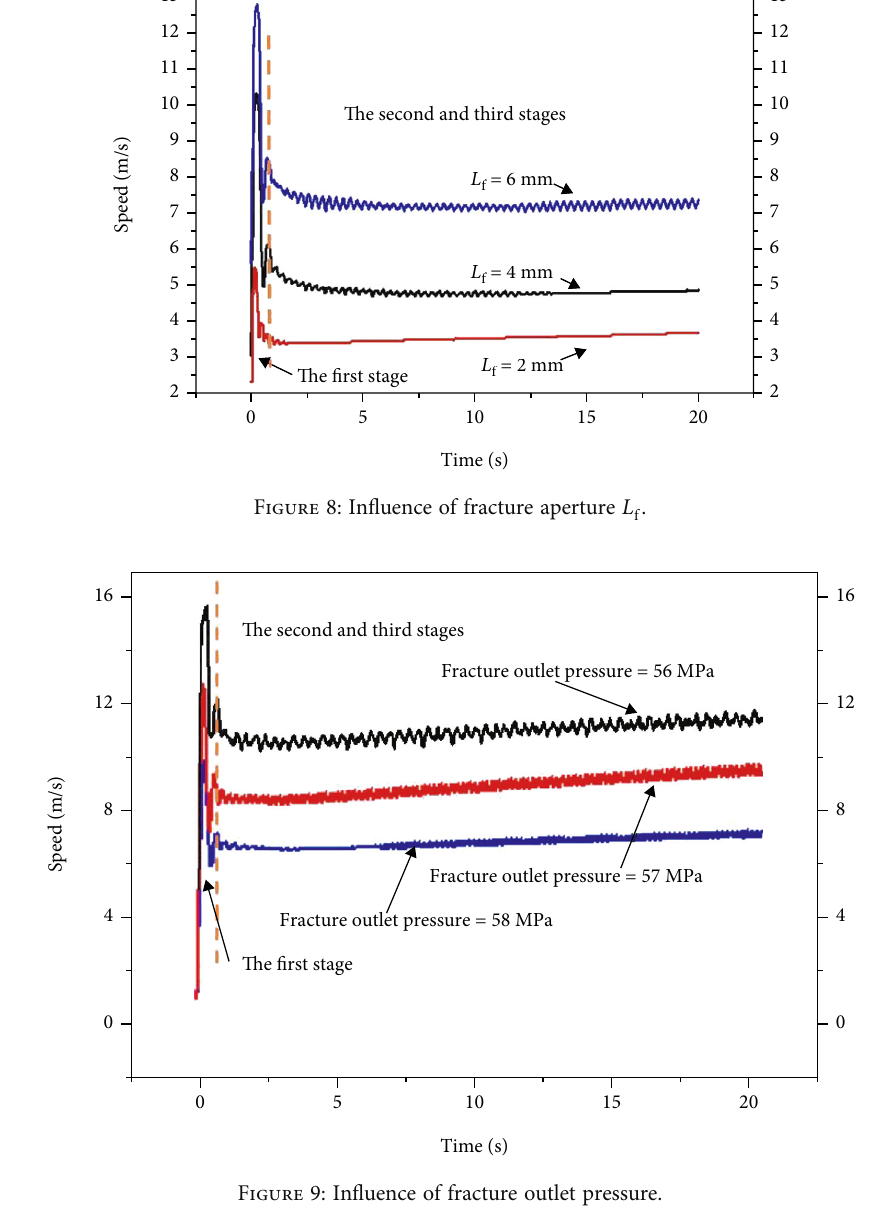
Figure 9: In fl uence of fracture outlet